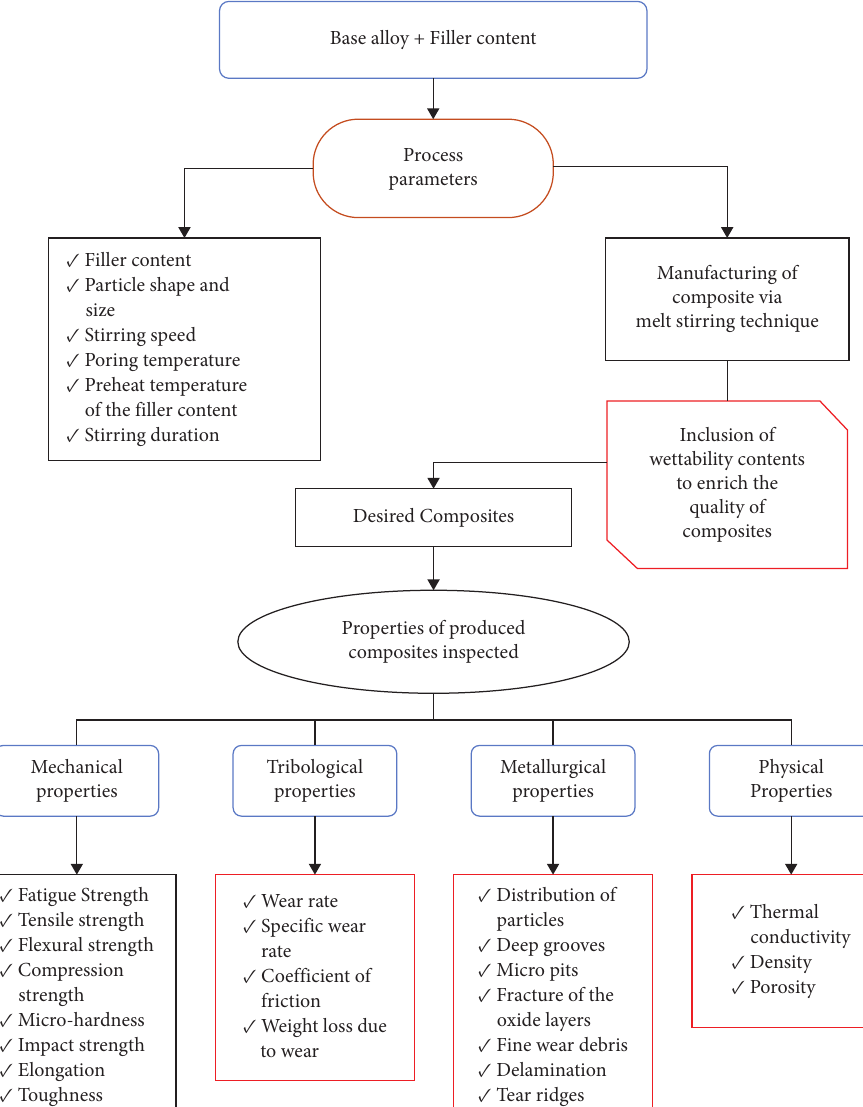
Figure 10: Experimental structure for the fabrication of composites through melt stirring